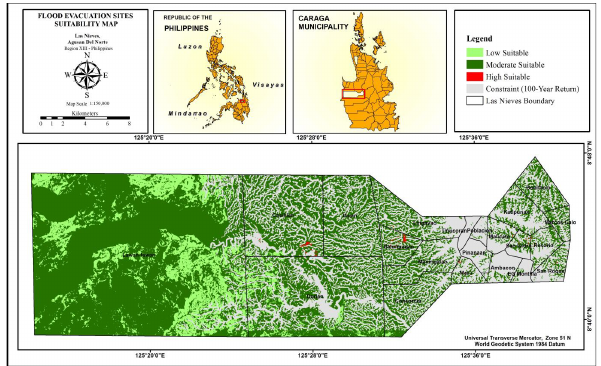
Figure 2. Flood Evacuation Sites Suitability Map in Las Nieves, Agusan del Norte